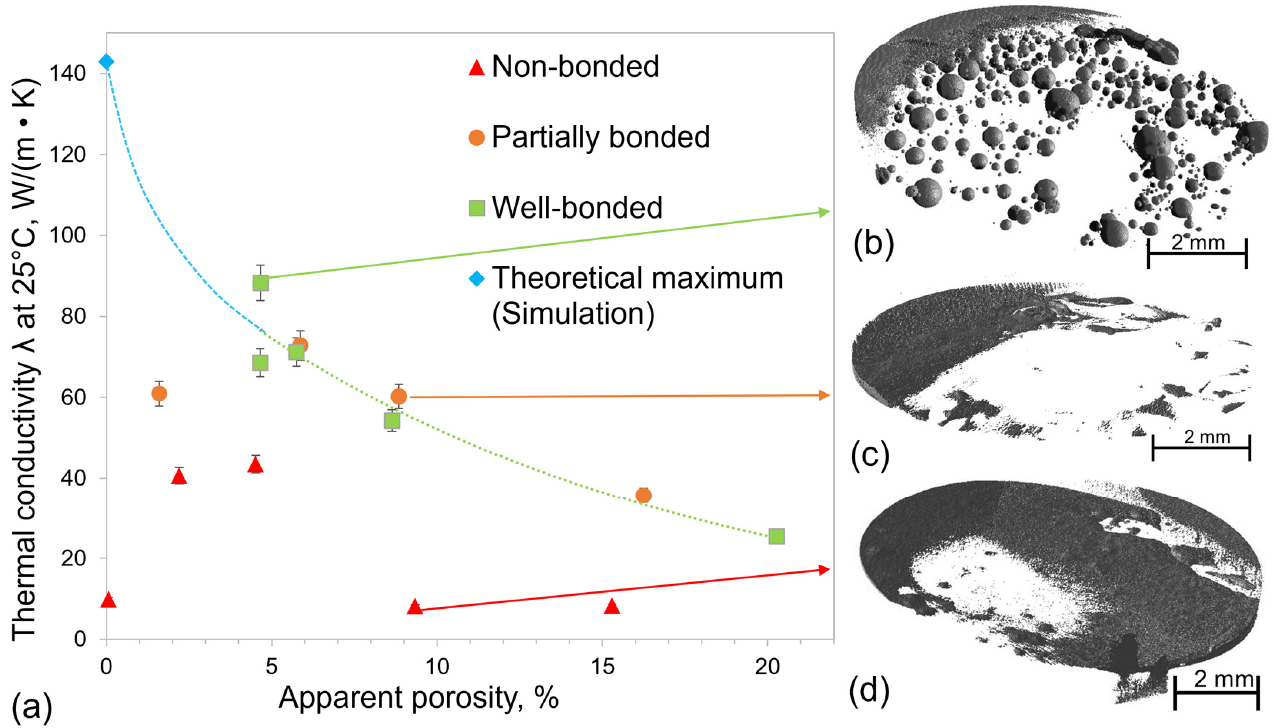
Figure 9. ( a ) Measured thermal conductivity of the compound zone for different apparent porosities, ( b ) representative samples which were considered as well-bonded, ( c ) partially bonded and ( d ) non- bonded; the maximum thermal conductivity for the compounds was taken from Ref. [29].